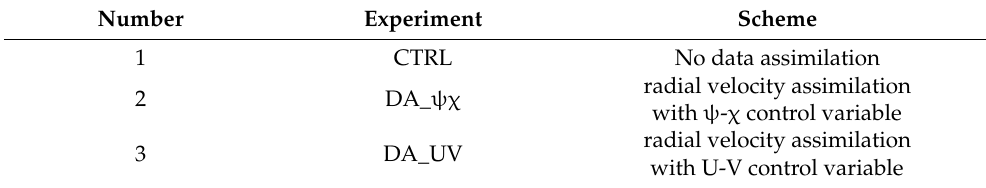
Table 1. Experiment scheme.